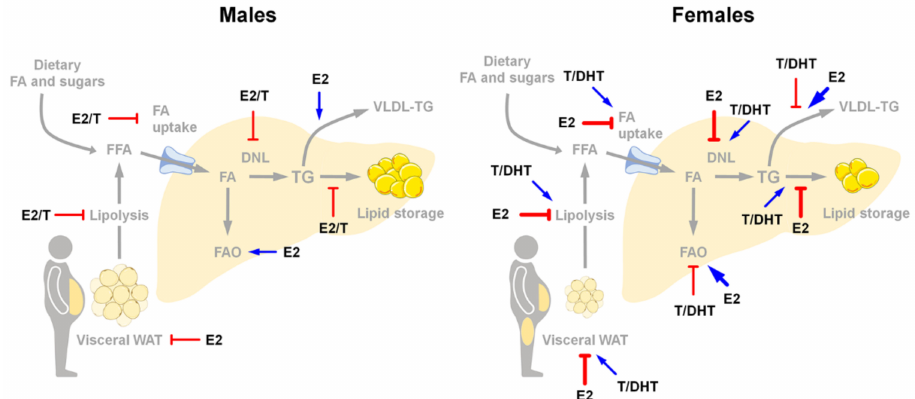
Figure 7. Sex-specific relevance of estrogens and androgens in the regulation of lipid metabolism in the liver of males and females accounting for differences in NAFLD susceptibility. In male liver, androgens and low levels of testosterone-derived estrogens partly limit lipid deposition by inhibiting adipose tissue lipolysis, FA uptake, and DNL, and by promoting FAO and lipid export. In female liver, estrogens prevent while high levels of androgens (especially DHT) promote lipid deposition, by differentially regulating adipose tissue lipolysis, FA uptake, DNL, FAO and lipid export. Abbreviations: DHT, dihydrotestosterone; DNL, de novo lipogenesis; E2, 17 β -estradiol; FA, fatty acids; FAO, fatty acid oxidation; T,